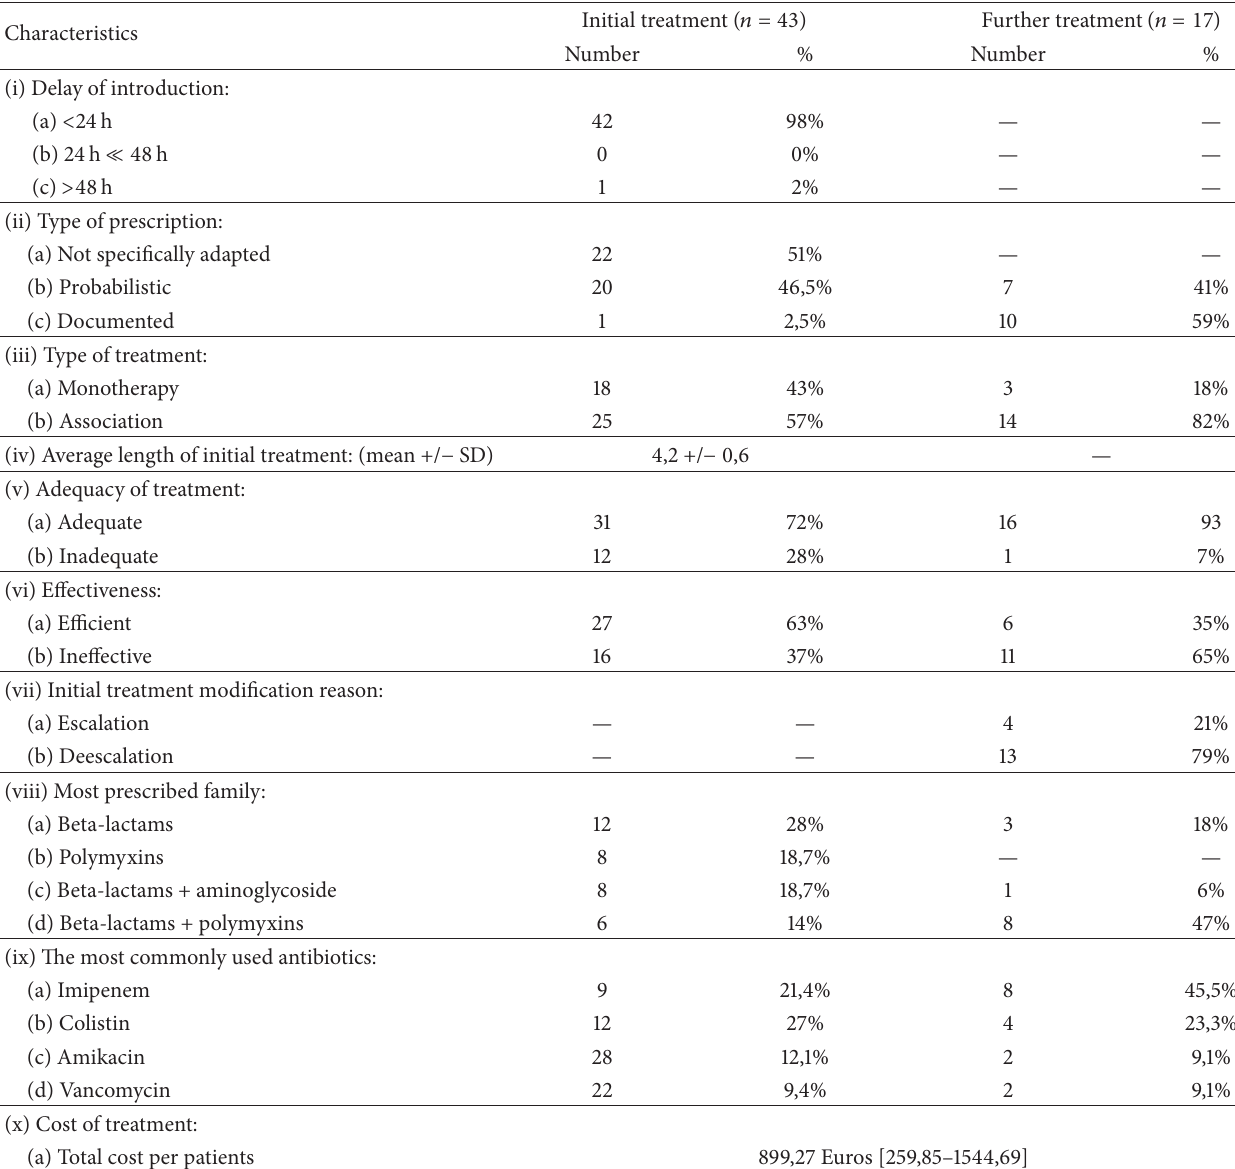
Table 4: Characteristics of antimicrobial